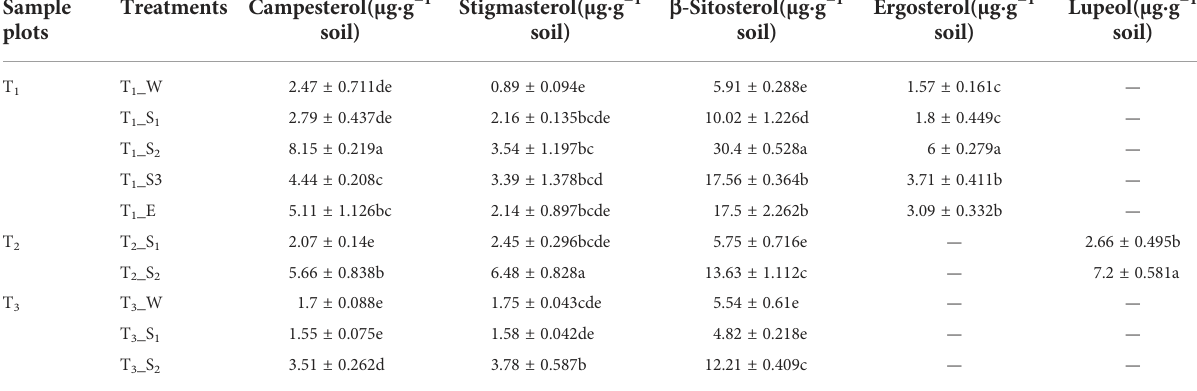
Values are means ± SE (n = 3). Different letters indicate statistically signi fi cant differences (p< 0.05) between the different samples by ANOVA. The number of soil samples is 30.